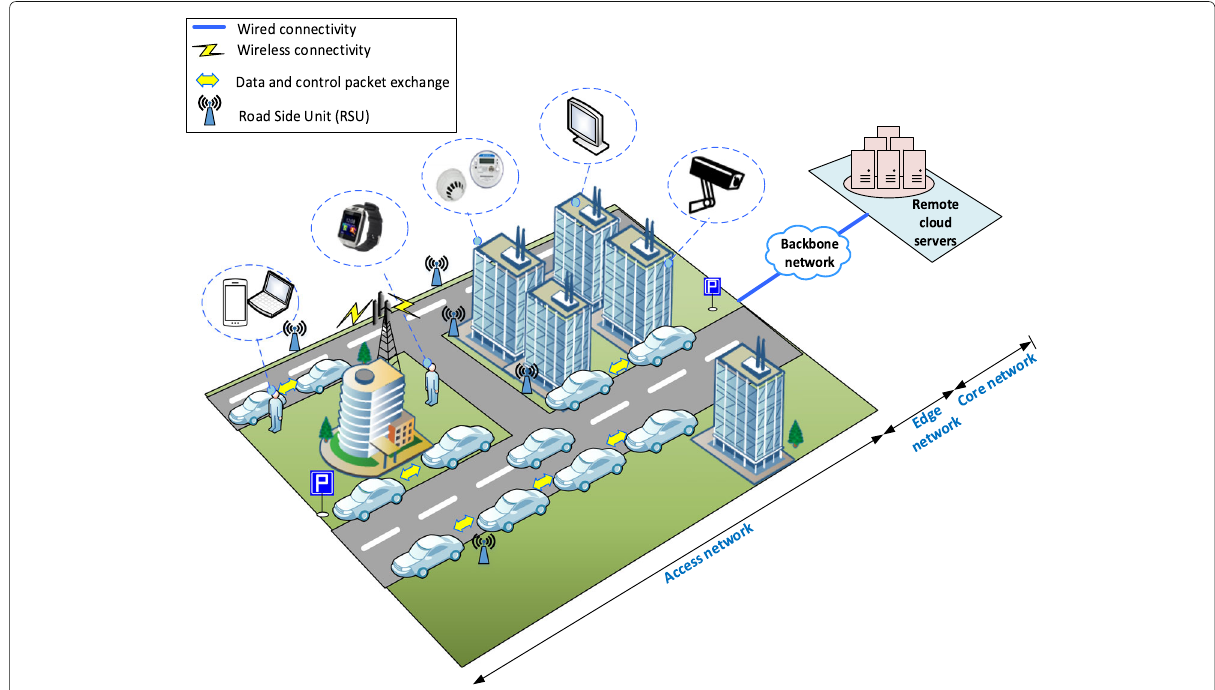
Fig. 1 Parked vehicles as a VFC infrastructure in on-street parking urban environment